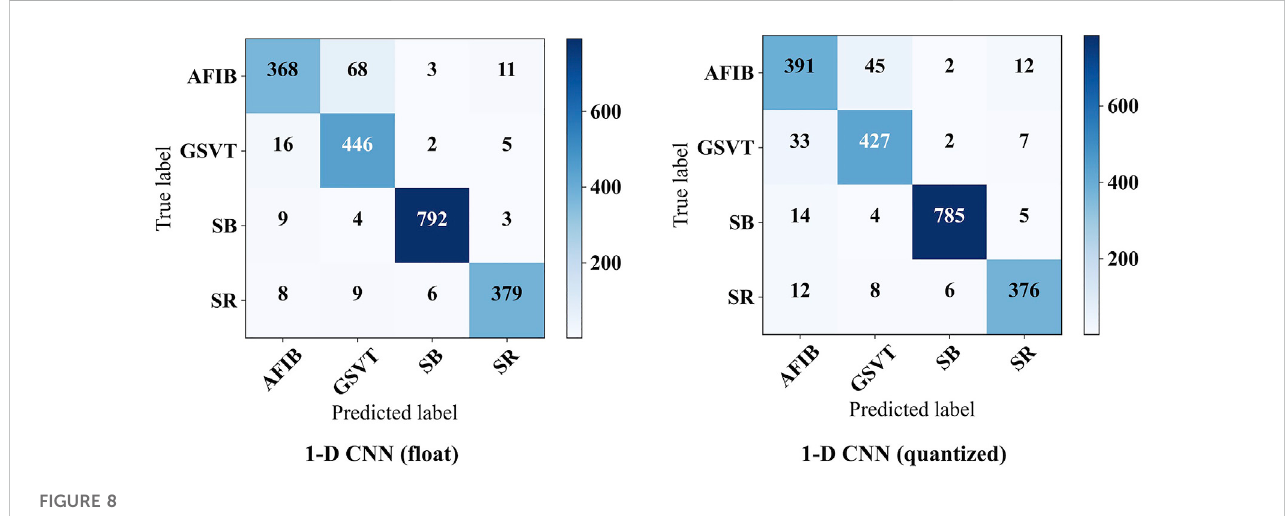
FIGURE 8 The confusion matrices on test set.